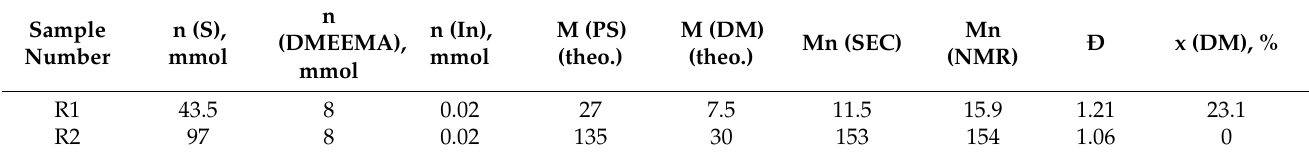
Table 2. Results of the ATRP of PS-b- PDMEEMA